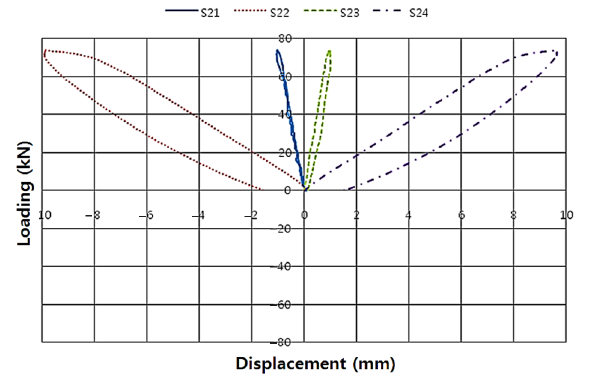
Fig. 12. Strain curves of rebar in PC beams under eccentric load of 73 kN